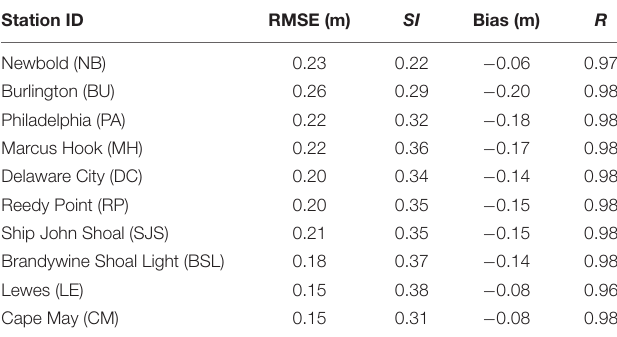
TABLE 2 | Error statistics of water-level predictions in the DBE.